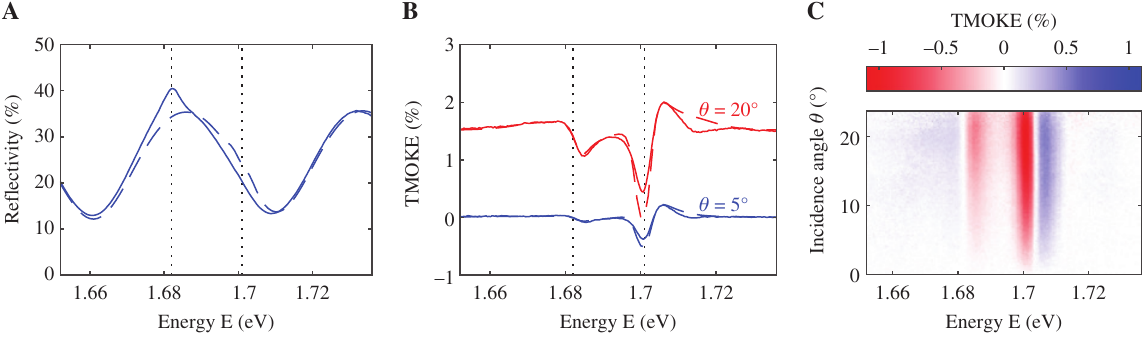
Figure 4: (A) Reflectivity spectrum from experiment (solid line) and theory (dashed line) at an incidence angle of θ = 5 ° and T = 10 K. (B) TMOKE spectra for θ = 5 ° (blue) and θ = 20 ° (red) at B = 580 mT and T = 10 K. The curves obtained for θ = 20 ° are shifted upward by 1.5% for clarity. Solid line refers to the experiment and dashed line corresponds to the theory. (C) Angular-resolved TMOKE spectrum in the excitonic spectral range in the case of a weak coupling regime at B = 580 mT and T = 10 K. Δ / Γ is different for lh and hh contributions: 1.79 for lh and 0.5 for